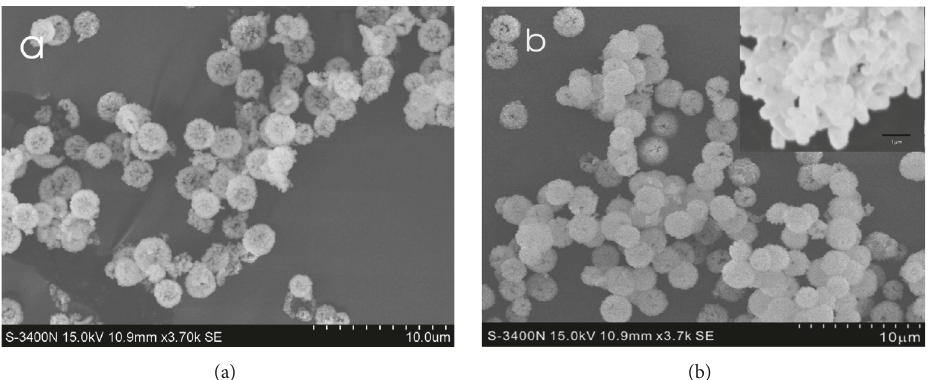
Figure 1: SEM images of the as-prepared microspheres, (a) hydroxyapatite, and (b) FA-grafted hydroxyapatite.